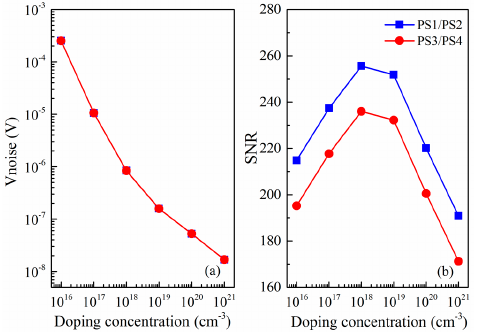
Figure 7. ( a ) Noise as function of doping concentration; and ( b ) SNR as function of doping concentration.